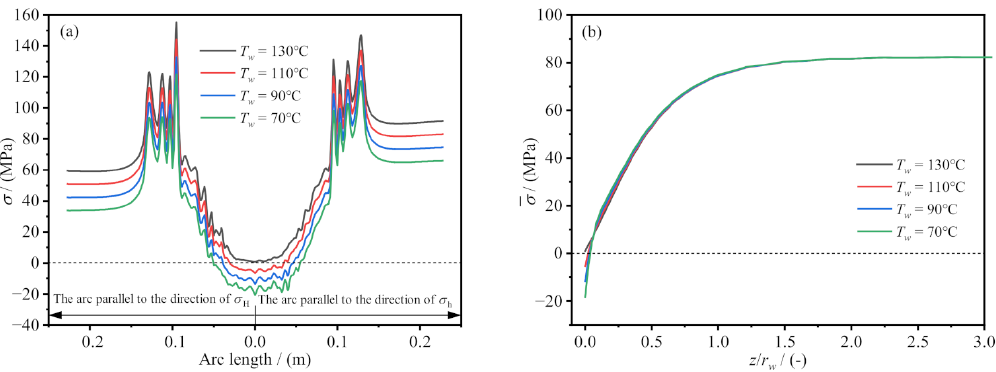
Figure 12. Average effective stress of the bottomhole rocks under different wellbore temperatures. ( a ) The arc parallel to the direction of σ H and σ h ; ( b ) The line along the axis of the